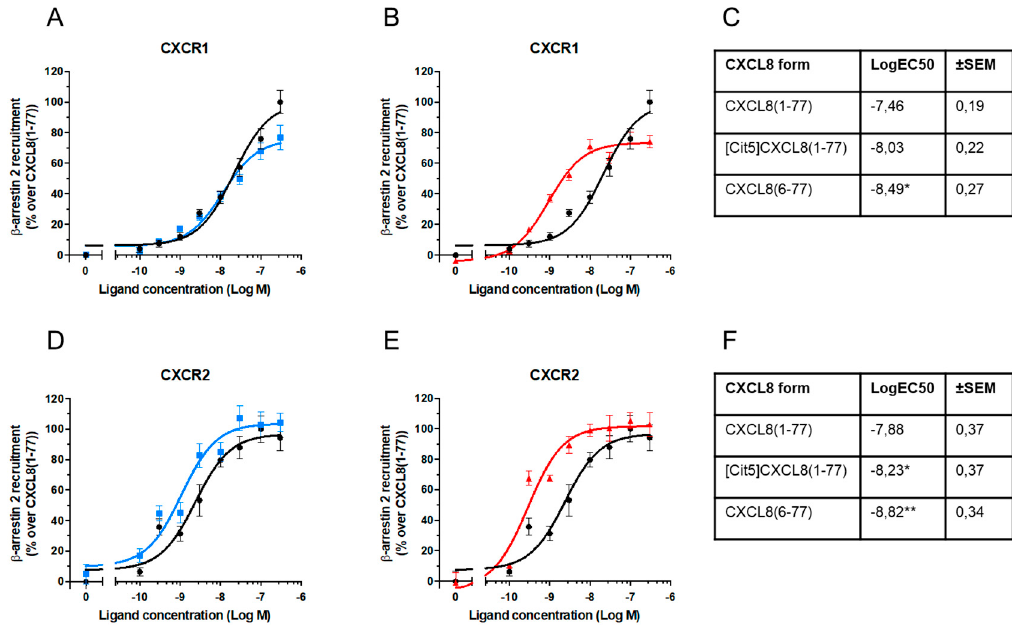
Figure 5. Dose-response evaluation of β -arrestin 2 recruitment induced by native and NH 2 -terminally processed CXCL8. One representative experiment is depicted showing dose-response measurements of net BRET ratio in HEK-293T cells transfected with β -arrestin 2-EYFP and CXCR1-RLuc ( A , B ) or CXCR2-RLuc ( C , D ) after stimulation with the indicated concentrations of CXCL8(1-77) ● , [Cit5]CXCL8(1-77) ■ or CXCL8(6-77) ▲ . Results are represented as percentages of activity in β -arrestin 2 recruitment over values obtained with authentic CXCL8(1-77) ± SEM. Mean LogEC50 ± SEM were obtained by nonlinear regression curve fitting in the β -arrestin assays ( n = 4) ( C,F ). Results were statically compared with one-way Anova test with Tukey multiple comparison. * p < 0.05, ** p <